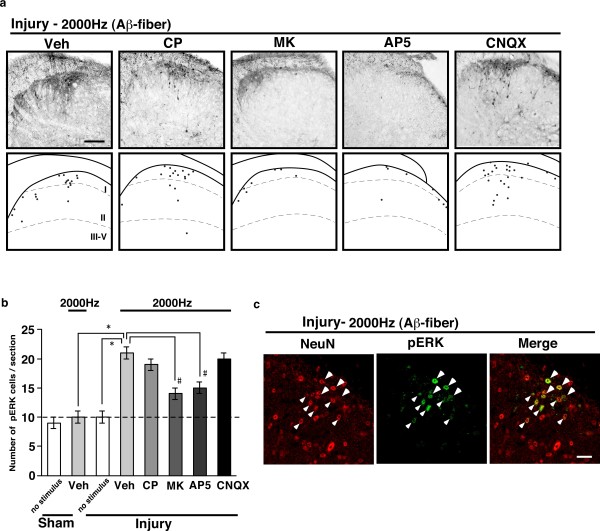
Altered spinal antagonisms of pERK signals induced by Aβ-fiber stimuli in nerve-injured mice. Representative pictures of spinal antagonisms of pERK signals induced by 2000 Hz stimuli (a) and the results of pERK quantification (b).: vehicle (Veh; aCSF), CP-99994 (CP) (10 nmol), MK-801 (MK) (30 nmol), AP-5 (30 nmol), CNQX (10 nmol). *: p < 0.05 vs. sham-vehicle or injury-no stimulus. #: p < 0.05 vs. injury-vehicle. Data represent the means ± S.E.M. from experiments using at least 4 mice. (c) Double-immunostaining images for pERK (green) and the neural marker NeuN (red) after Aβ-fiber stimuli in the spinal cords of nerve-injured mice. Scale bar = 100 μm for (a) and 20 μm for (c).